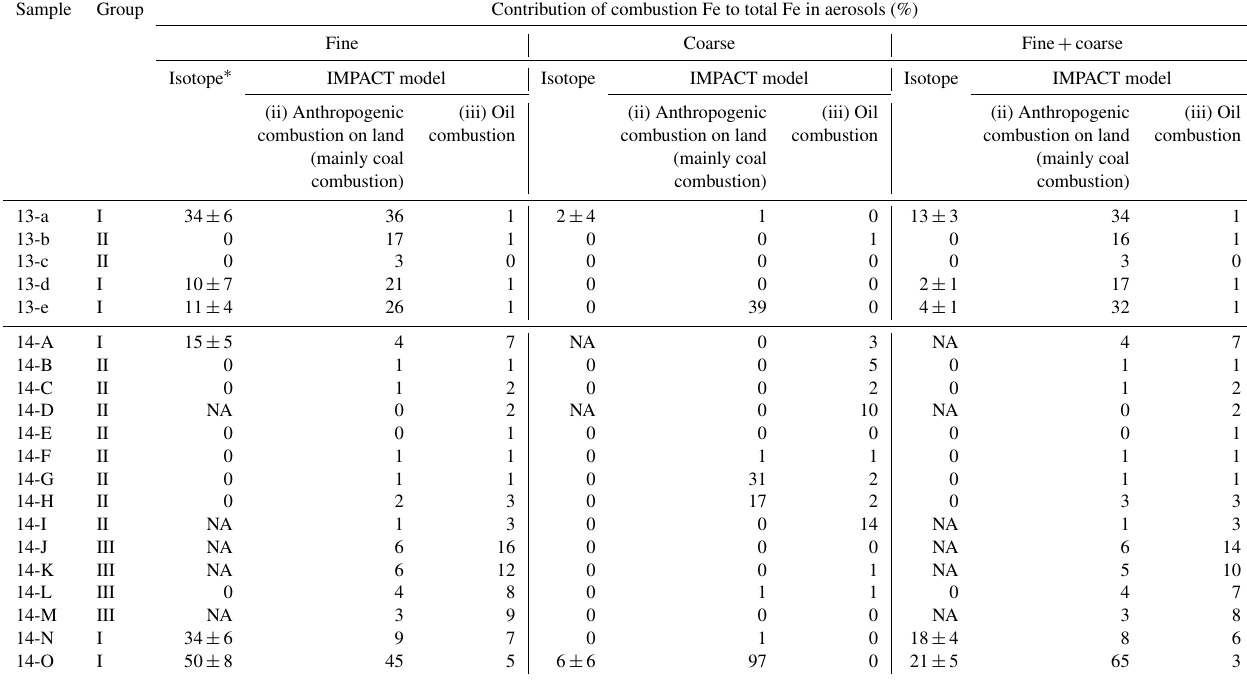
Table 1. Comparison of the contribution of combustion Fe to total Fe estimated by the Fe isotope ratio and the IMPACT model. ∗ Errors were calculated based on 2SD of the δ 56 Fe of samples and combustion